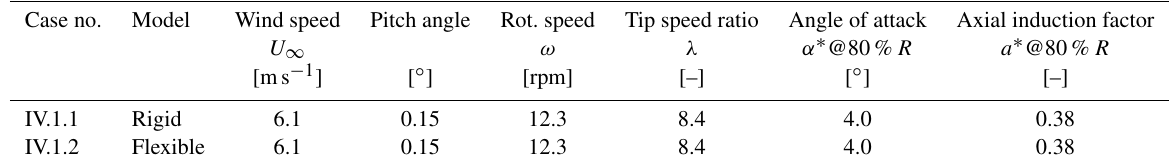
Table 2. DanAero comparison cases (axial flow). Case no.